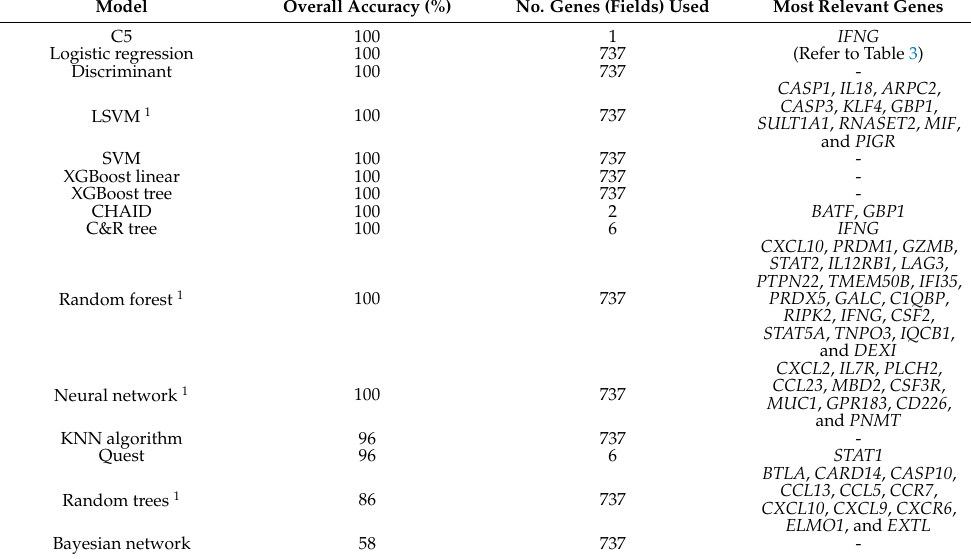
Table 2. Machine learning and artificial neural network analysis for predicting celiac disease.